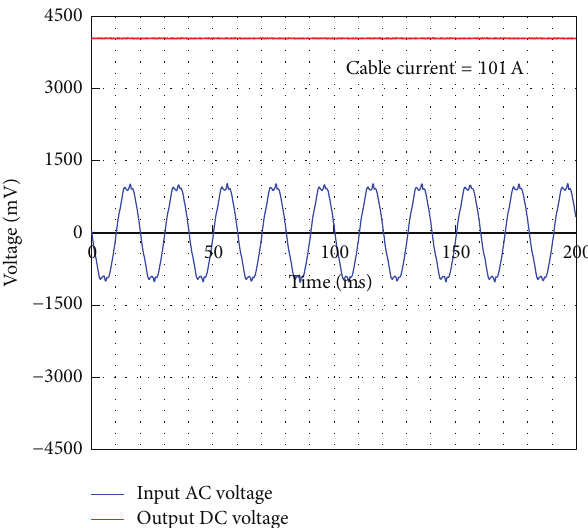
Figure 22: AC and DC voltage levels produced by the inductive energy harvester, prototype-5 at a cable current level of 101 A.